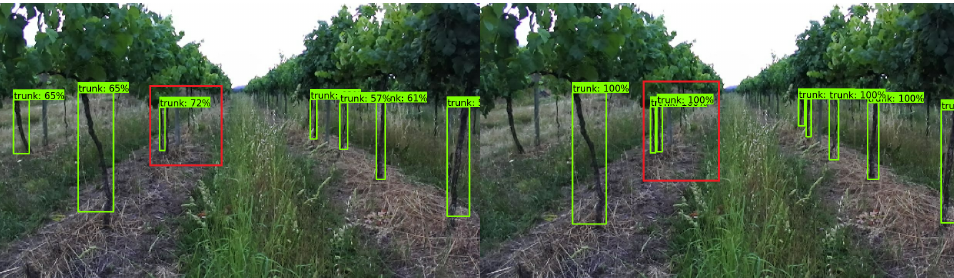
Figure 15. Two trunks are close together and the model cannot detect both.